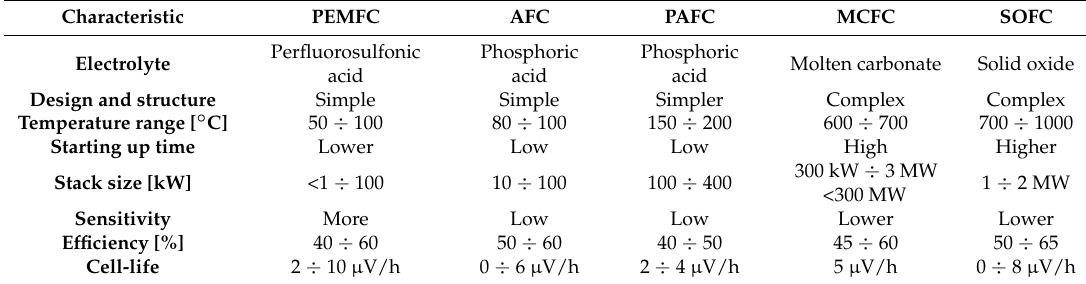
Table 9. Fuel Cell Specifications